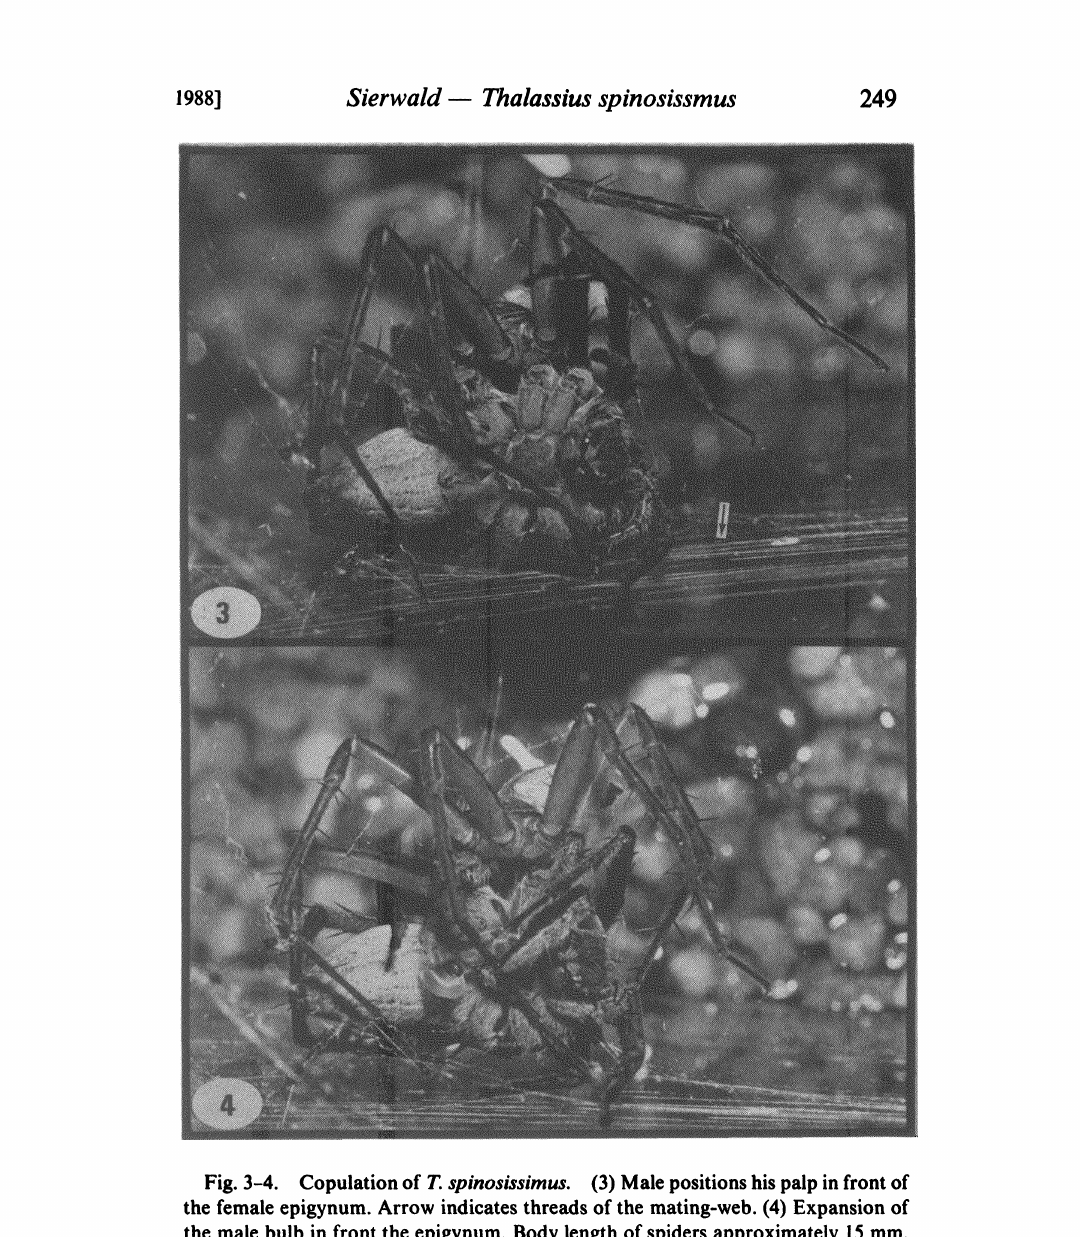
Fig. 3-4. Copulation of T. spinosissimus. (3) Male positions his palp in front of the female epigynum. Arrow indicates threads of the mating-web. (4) Expansion of the male bulb in front the epigynum. Body length of spiders approximately 15